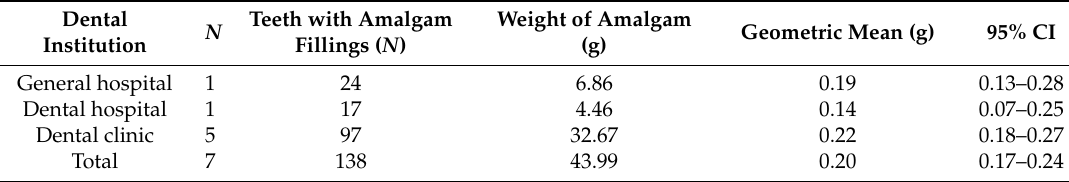
Table 2. Weight of amalgam by dental